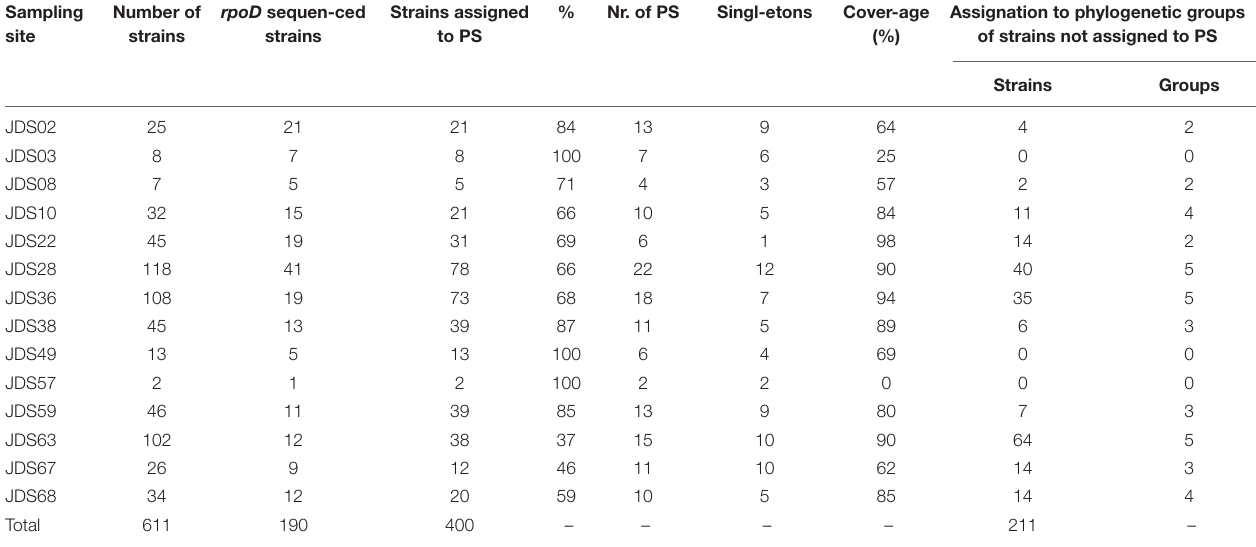
TABLE 4 | Assignation to species or phylospecies of the MDR strains and their corresponding sampling sites of isolation.